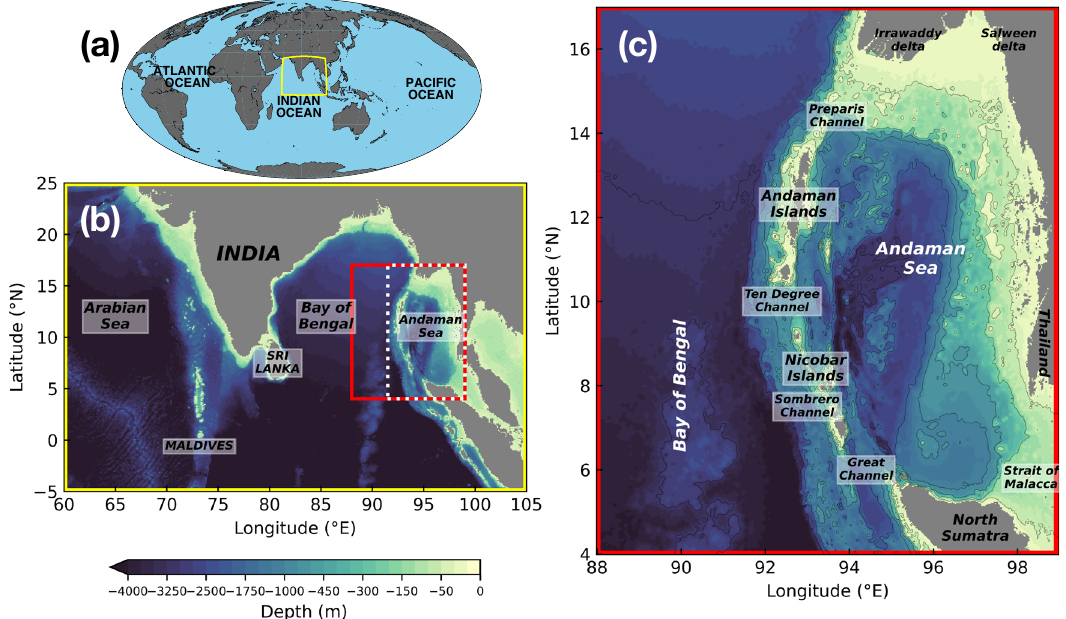
Fig. 1 Andaman Sea and model domain. a Global map highlighting the northern Indian Ocean region in yellow. The bathymetry of the ( b ) northern Indian Ocean and ( c ) the Andaman Sea is derived from GEBCO. The red box indicates the model domain, and the white box indicates the region over which the strati fi cation is averaged (see 'Methods'). A non-linear colour bar is used. The appropriate copyright information for the GEBCO data are available